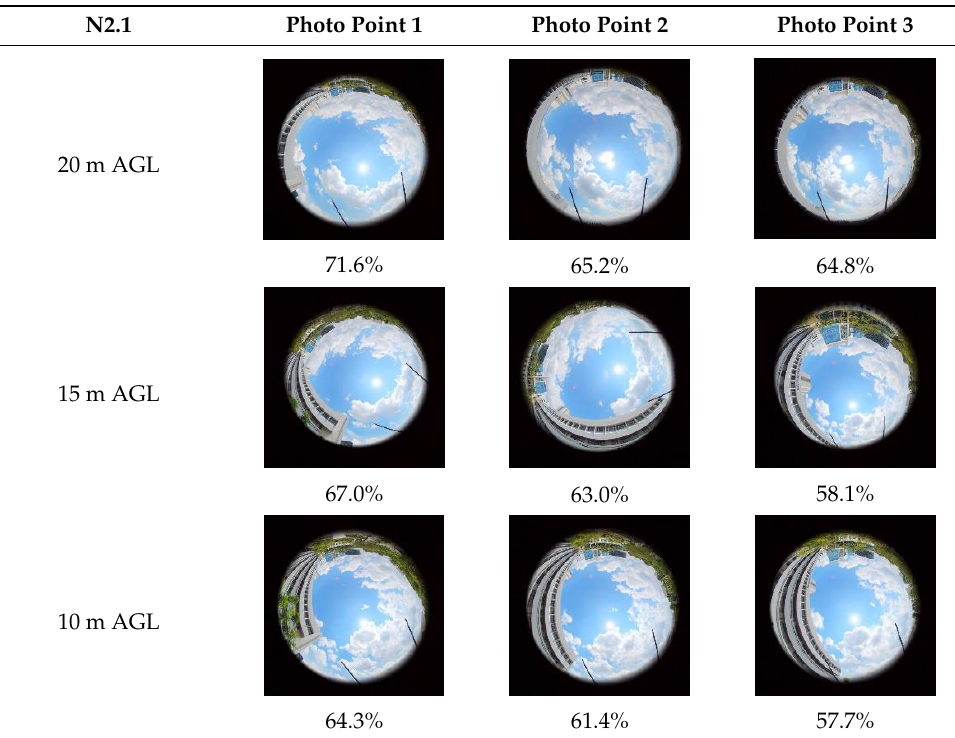
Figure 20. Boxplot of Measured Horizontal Error vs. Sky Ratio at N2.1.